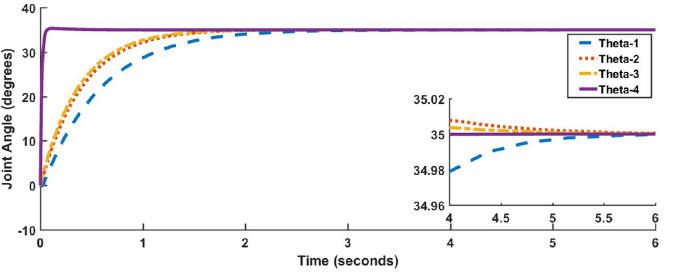
Fig 7. SFG-SISO PI response, Case I.